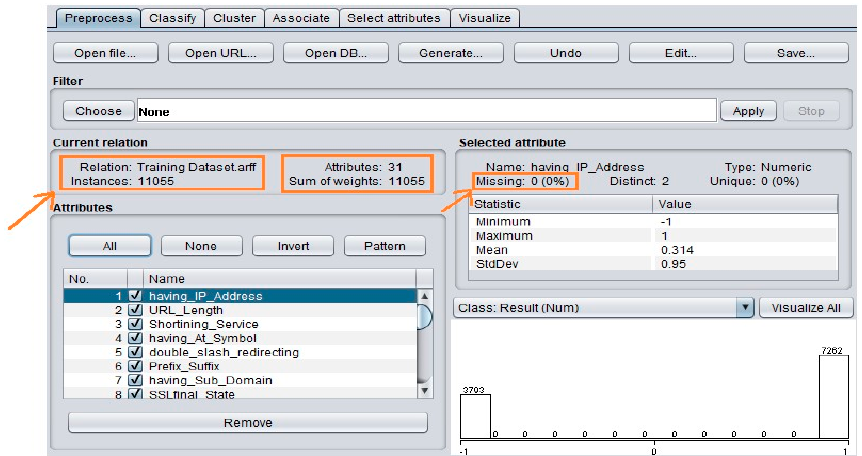
Figure 1. Information of phishing dataset in preprocessing step.